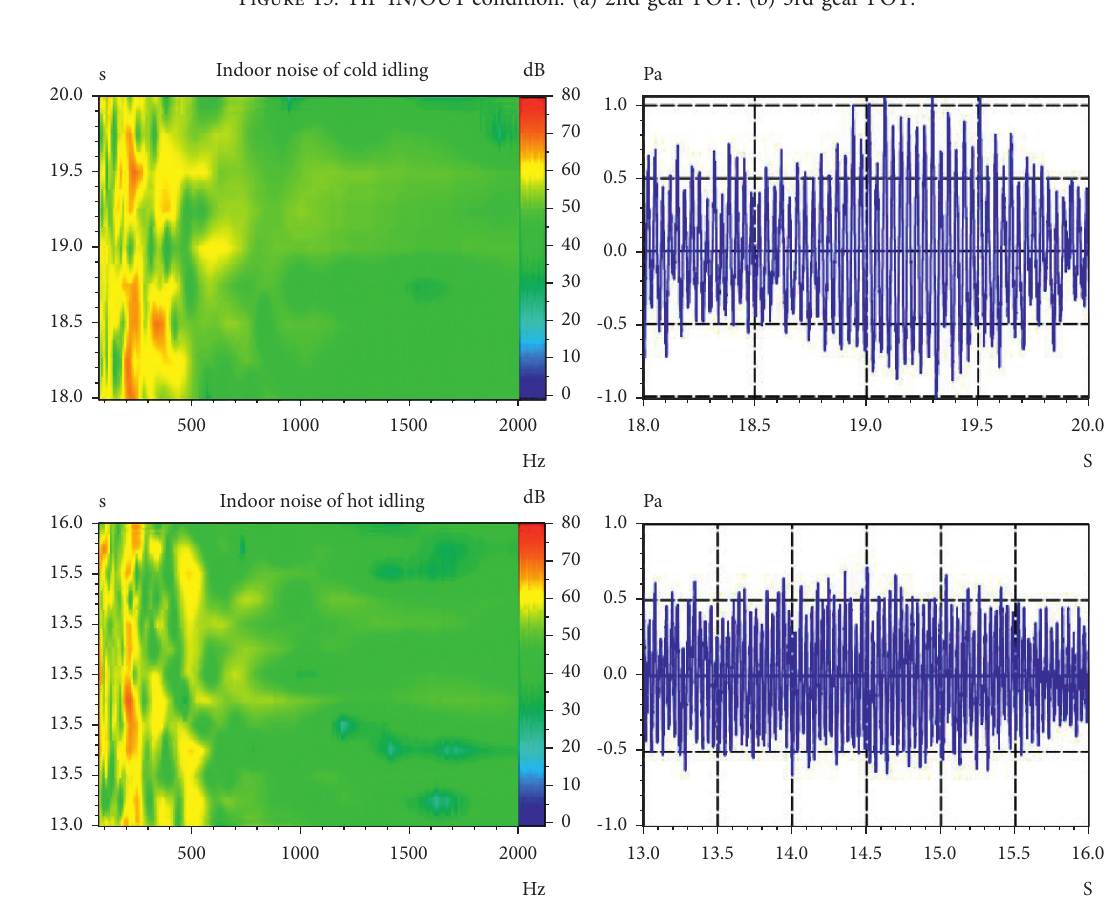
Figure 16: Noise spectra in the